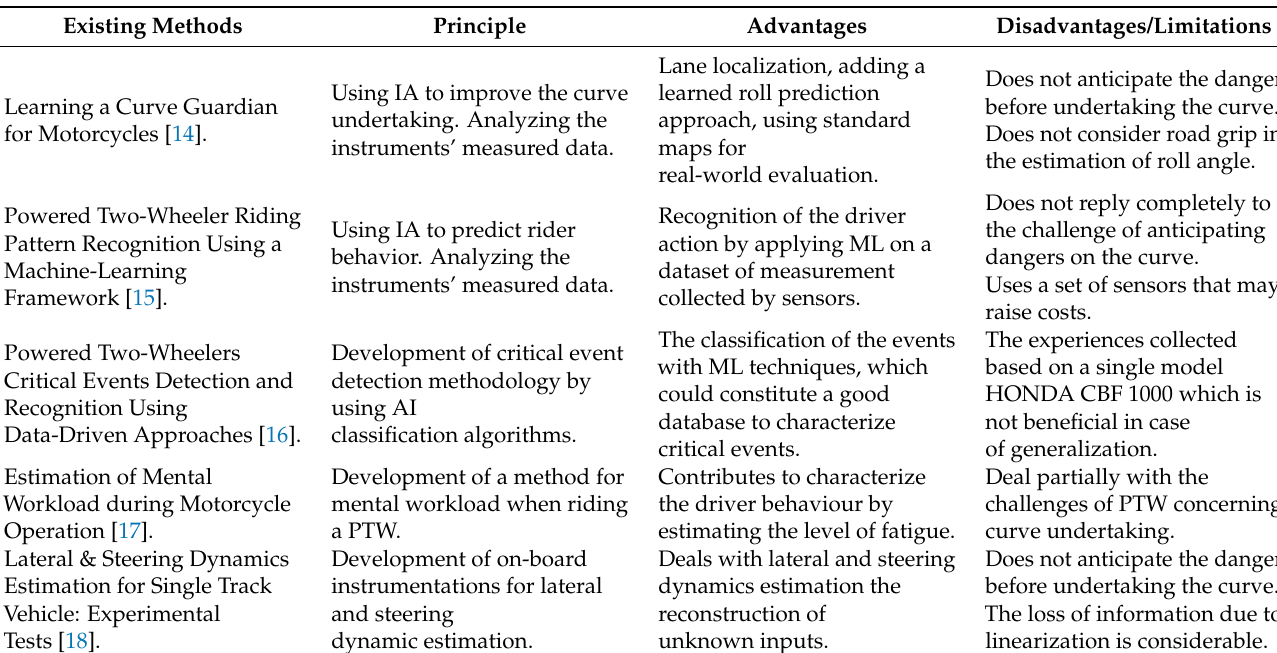
Table 1. Principle, main advantage and disadvantage of existing